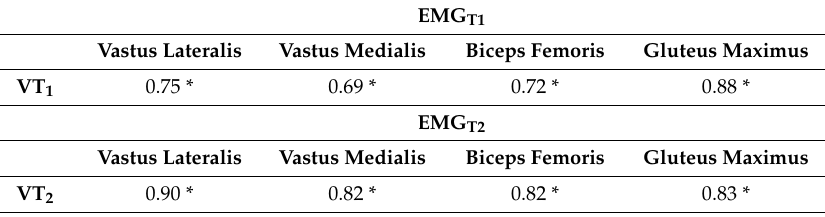
Table 4. Correlations between the power output (W) obtained at the first electromyographic threshold (EMG T1 ) and at the first ventilatory threshold (VT 1 ), and between the power output obtained at the second electromyographic threshold (EMG T2 ) and at the second ventilatory threshold (VT 2 ). EMG T1